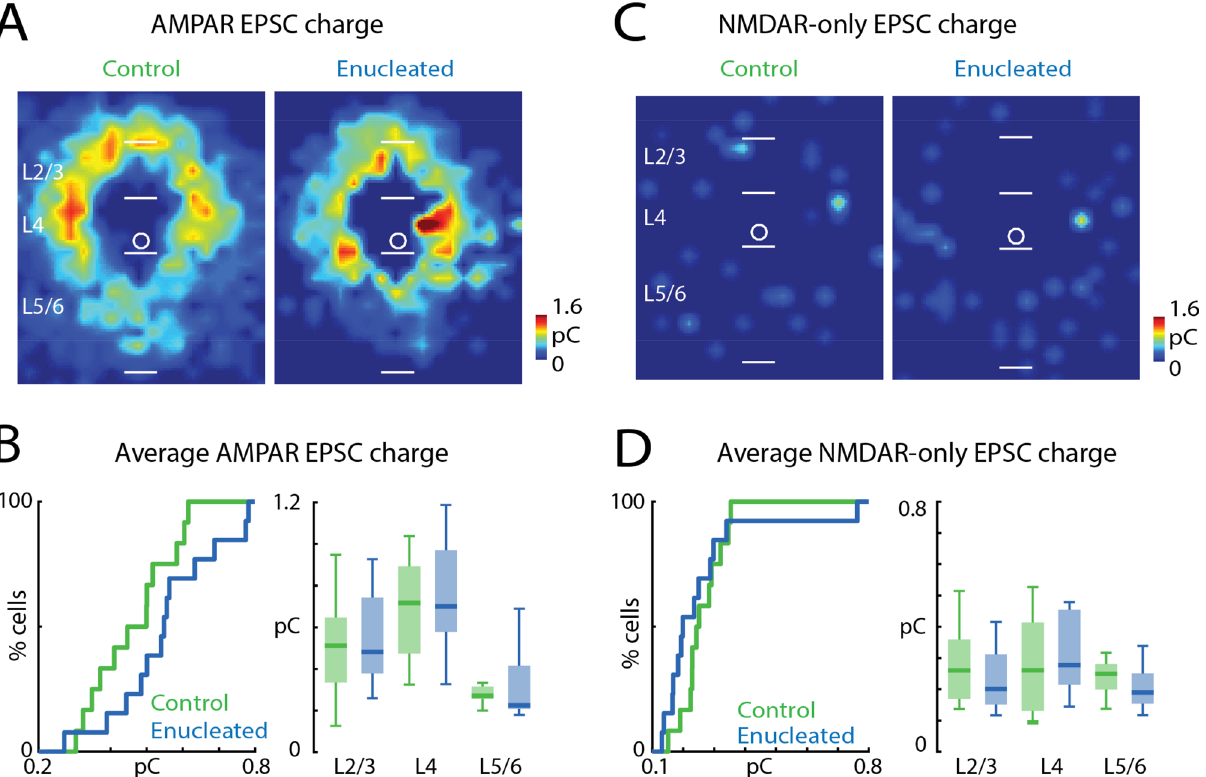
Figure 8. Strength of synaptic connections in PV interneurons is not altered by enucleation. ( A ) Average EPSC charge of AMPAR-mediated inputs received by PV interneurons in control and enucleated mice. ( B ) Quantification of AMPAR-mediated EPSC transferred charge. CDF of average transferred charge for each cell (left) and for inputs from each layer group (right). P > 0.05. ( C ) Average EPSC charge of NMDAR-only inputs received by PV interneurons in control and enucleated mice. ( D ) Quantification of NMDAR-only EPSC transferred charge. CDF of average transferred charge for each cell (left) and for inputs from each layer group (right). P > 0.05. For ( A ) and ( C ), white bars mark layer boundaries. The length of the white bars is 100 µm. Input locations are color-coded based on the average EPSC charge (pseudocolor scale to the lower right of each panel). For all panels: green, control group; blue, enucleation group. Statistics for ( B ) (left) and ( D ) (left) are in the main text. Statistics for ( B ) (right) and ( D ) (right) are in Table 8. Figure 8B: average EPSC transferred charge in each layer group Layer groups